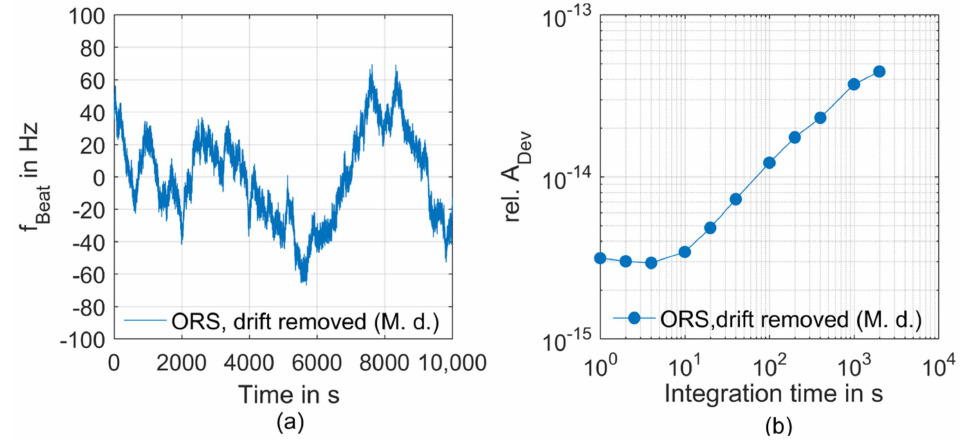
Figure 5. Frequency stability of the ORS as retrieved from manufacturer data (M.d.). ( a ) Time dependent beat frequency between two optical reference systems of comparable frequency stability with linear drift removed, ( b ) corresponding relative Allan deviation (see Section